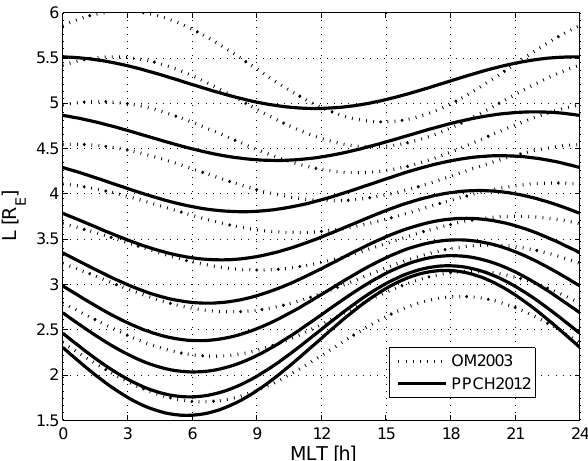
Fig. 13. Diurnal variation of the PP radial distance from the PPCH- 2012 model (solid) and the OM2003 model (dotted) at Kp=0.5, 1.5, ... 8.5. For details see